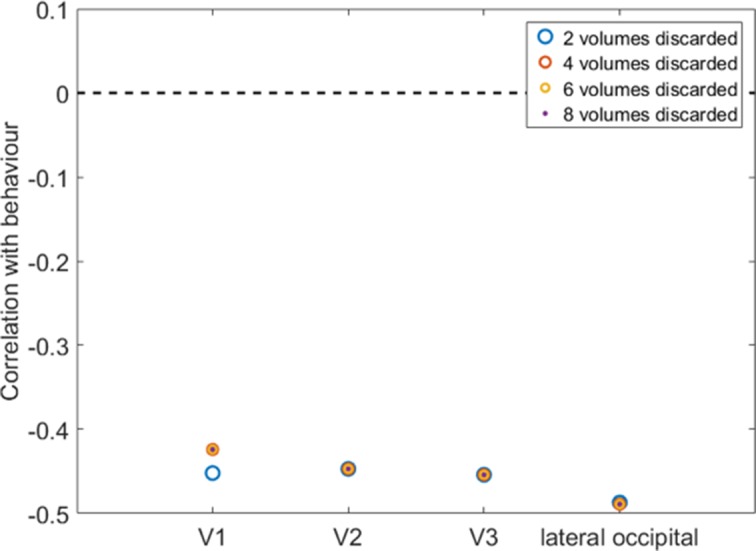
Visual cortex relationships with imagery strength and the number of EPI volumes discarded at the beginning of the run.To allow for longitudinal magnetization equilibration to stabilize, it is standard to remove at least the first two (or more) volumes from the measurement. With a TR of 2 s, our analyses were conducted after exclusion of the first 2 volumes (blue mcircles). To ensure that this number was not too low, potentially causing the results to still be prone to magnetization artifacts, we re-analyzed the data after excluding 4 (red circles), 6 (yellow circles), and 8 volumes (purple circles). Irrespective of the number of discarded volumes at the beginning of the measurement, imagery strength correlations with visual cortices V1, V2, V3, and lateral occipital area remained almost identical.